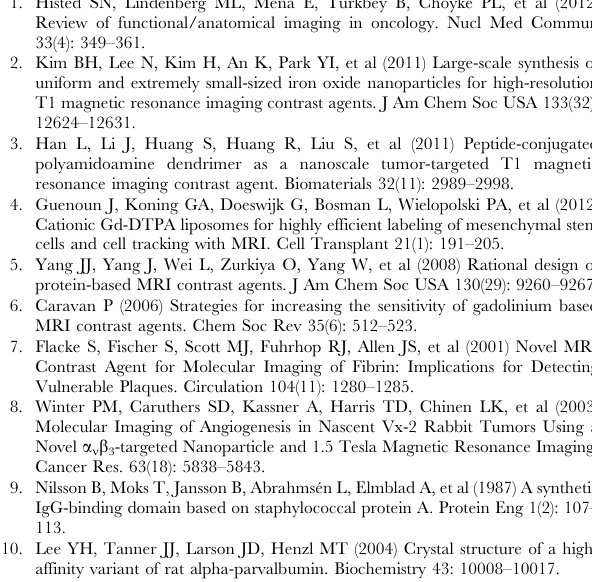
Figure S4 Controls. Controls of the cell based experiment in which A431 cells were incubated with the complex Zarvin-D72C- Atto-594:Cetuximab (Figure 1C of the main text). Figure S5 Affinity measurements of Lanthanide ion binding. Left, titration of 3 m M TbCl 3 and 8 m M Zarvin with NTA. Luminescence of Terbium (III) was recorded. The curve was normalized and inverted prior to fitting. It was known from an active site titration that binding of Tb 3 + to the EF-site (5–6 6 higher Ca 2 + affinity than the CD-site 4 ) contributes to a larger amount to the overall luminescence measured (approximately 5 6 ). This effect produces a quasi-cooperative behavior of the luminescence signal upon titration with NTA, forming a sigmoidal curve. The global IC 50 value of the curve does not vary to a large extent when either estimated or fitted as a K app using a Hill equation due to the sigmoidal shape of the curve. K app stands for the apparent K D of the NTA:Tb 3 + complex in the presence of Zarvin. As the luminescence contribution of Tb 3 + in the EF-site dominates the global IC 50 /K app value, an approximately 5–6 6 lower affinity can be assumed for the CD-site, analogous to the binding behavior of Ca 2 + . Right, competition titration of 4 m M Zarvin and 10 m M TbCl 3 with GdCl 3 and CaCl 2 , respectively. Luminescence of Terbium(III) was recorded. K app stands for the apparent K D of the Zarvin:Gd 3 + or Zarvin:Ca 2 + complexes in the presence of Tb 3 + . Figure S6 NMRD profile of Zarvin:(Gd 3 + ) 2 . The NMRD profile confirms the high efficiency of Zarvin:(Gd 3 + ) 2 measured at clinically used MRI devices in terms of the relaxivity r 1 . The relaxivity of Zarvin:(Gd 3 + ) 2 at 1.5 Tesla and 37 u C (between the last and last but one point in the profile referring to 60 and 70 MHz, respectively, and considering 42.58 MHz per Tesla) is a